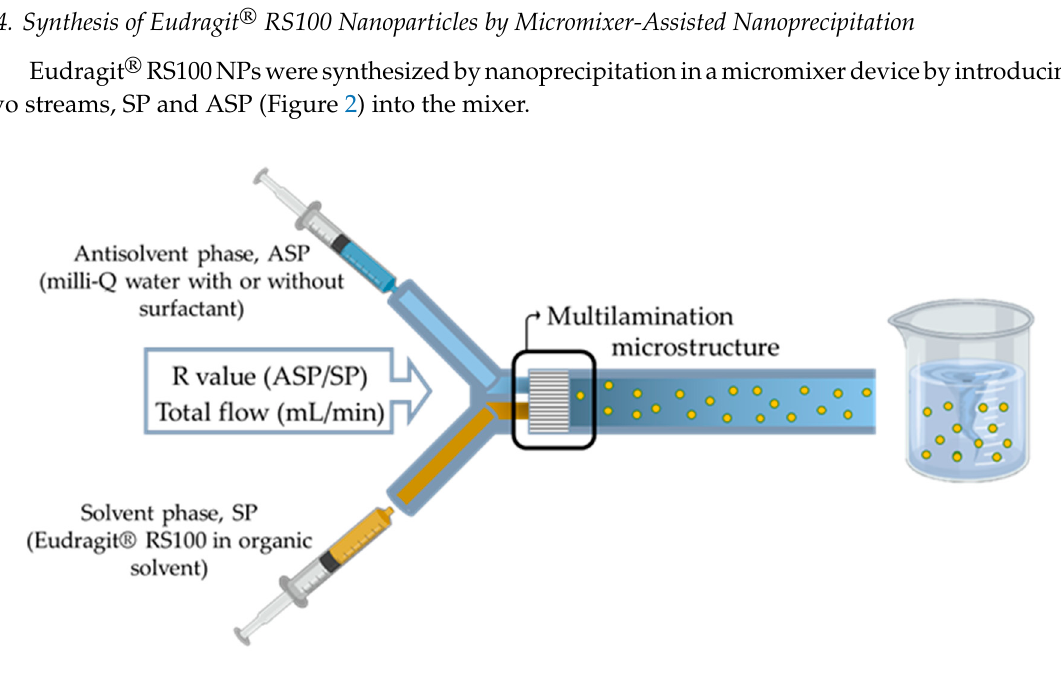
Figure 2. Schematic representation of the micromixer-assisted nanoprecipitation method and the main variables attuned to control the particle size distribution.